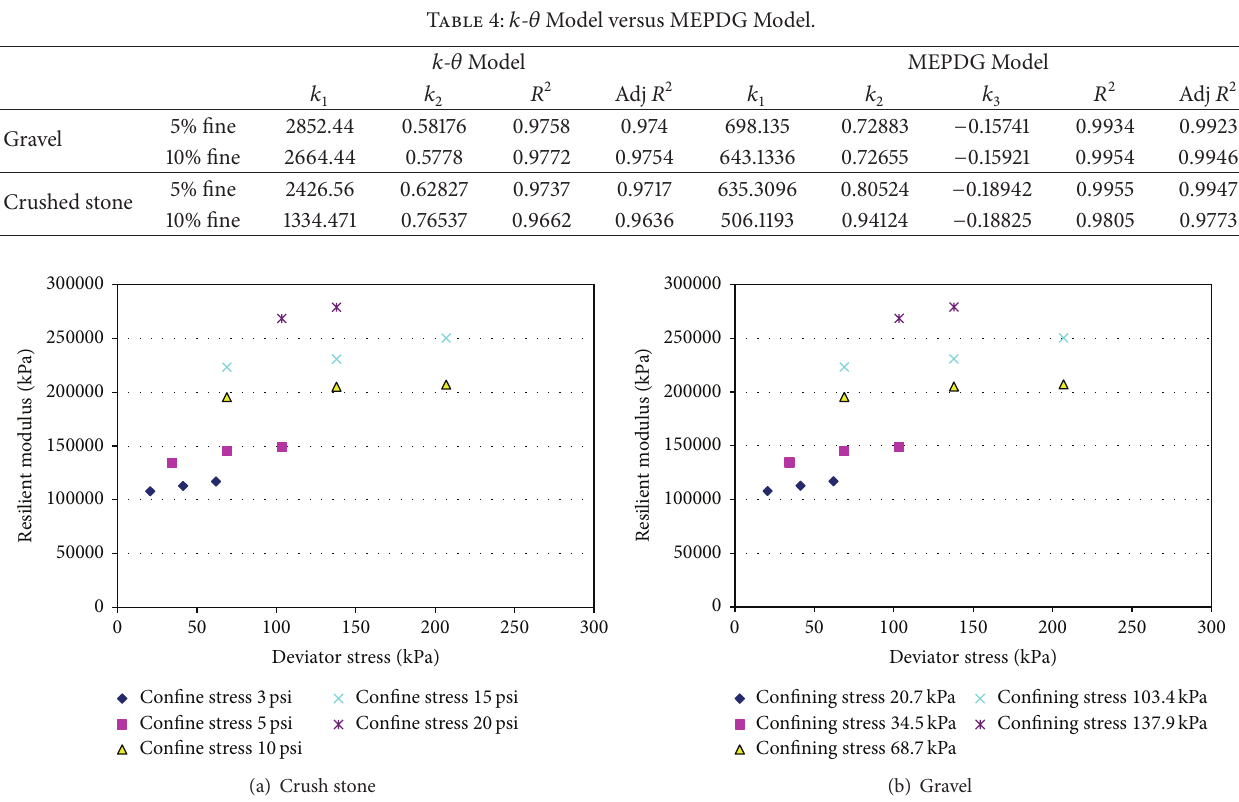
Figure 4: Laboratory resilient modulus for unbound materials at different confining and deviator stresses.